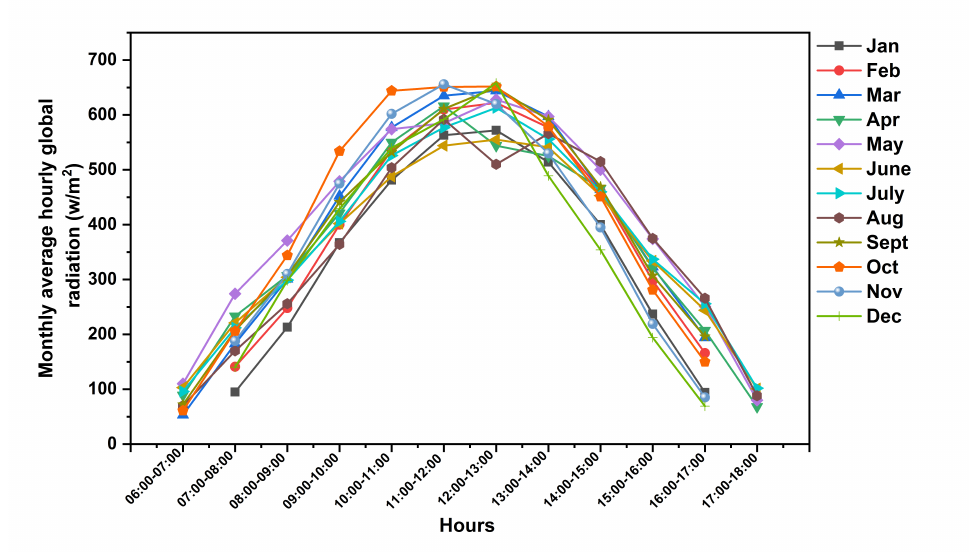
Figure 3. Monthly average hourly global solar